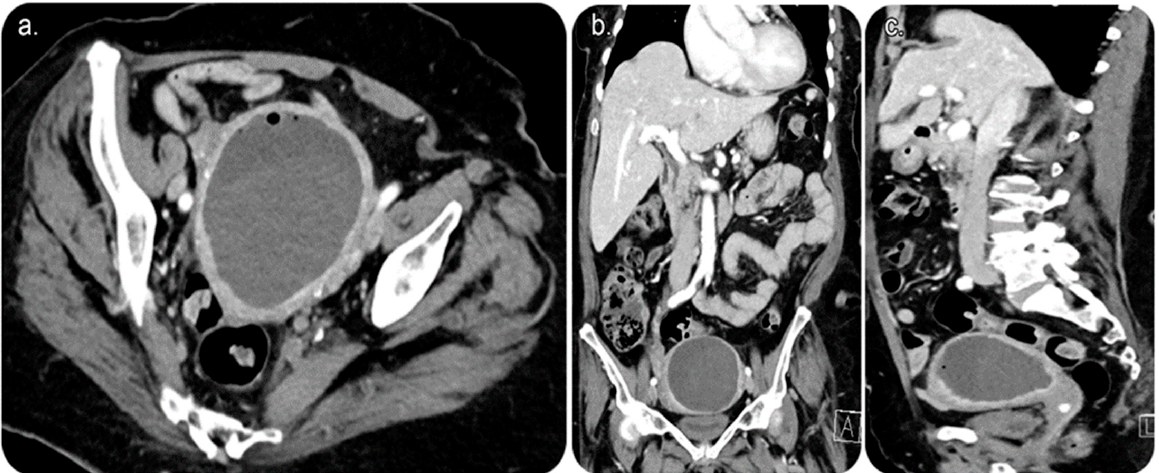
Figure 1. Reformatted computed tomography (CT) images of the abdomen and pelvis with (intra- venous) IV contrast. ( a ) Axial cut CT of the pelvis showing an endometrial fluid collection with air focus at the non-dependent part of the endometrium. The endometrial lining shows an evident contrast enhancement. No CT evidence of anterior abdominal scar is seen, proving no prior history of Caesarean birth. ( b ) Coronal and ( c ) sagittal CT of the abdomen and pelvis showing endometrial fluid collection with an air focus at the non-dependent part of the